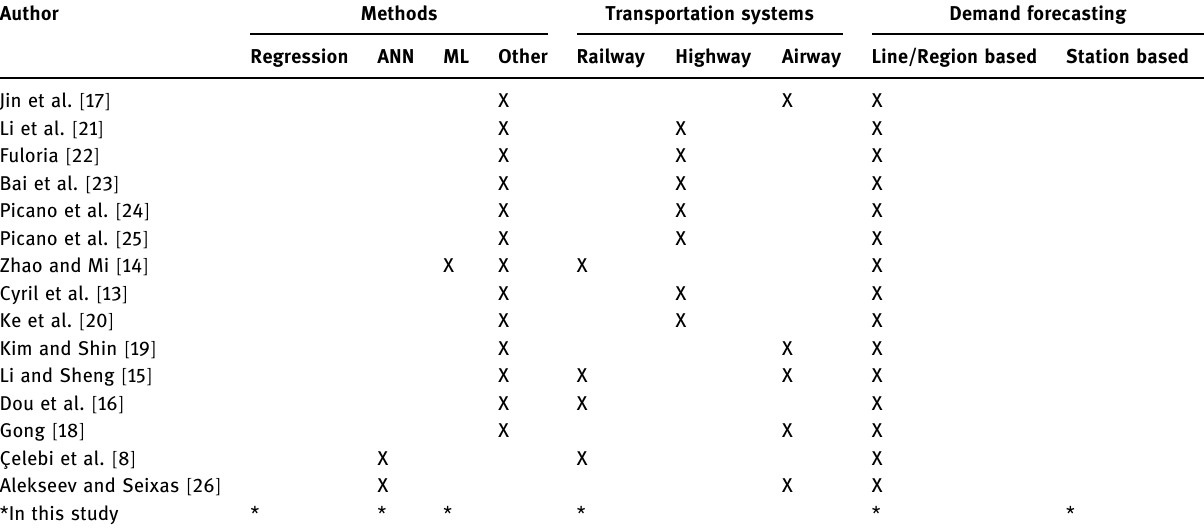
Table 1: Literature summary